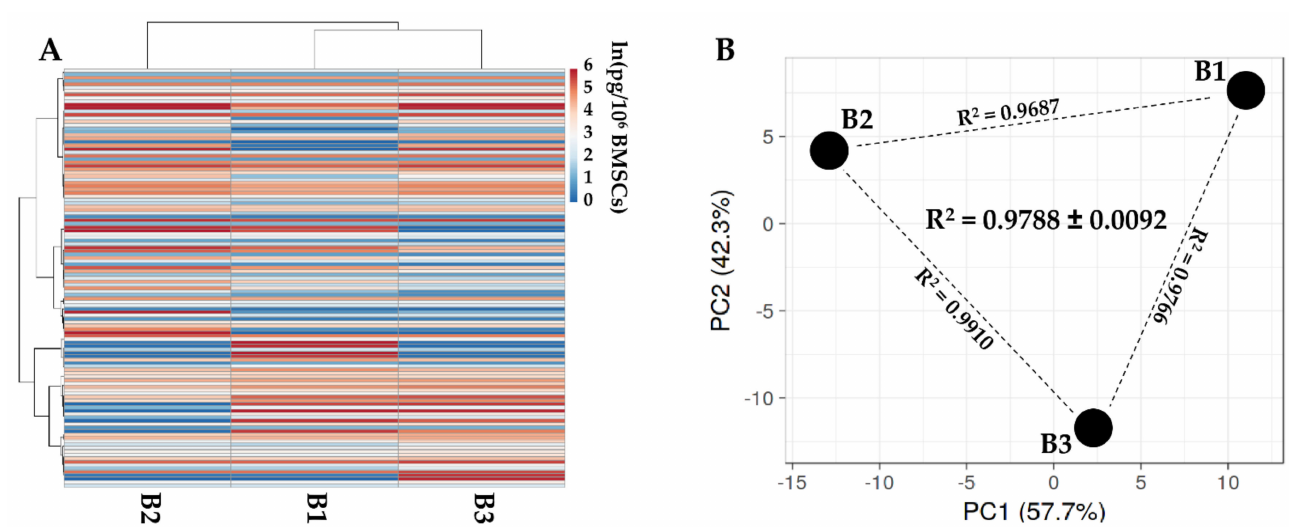
Figure 2. Comparison of secreted factor profiles between SF-treated BMSCs under study. ( A ), heat map of hierarchical clustering analysis of the ln(x) transformed pg/million BMSCs values of detected factors with sample clustering tree at the top. The color scale reflects the absolute expression levels: red shades = high expression levels and blue shades = low expression levels. B1, B2 and B3 stands for BMSC donors 1, 2 and 3. ( B ), principal component analysis of the ln(x) transformed pg/million BMSCs values of detected factors. X and Y axes show principal component 1 and principal component 2, which explain 57.7% and 42.3% of the total variance. B1, B2 and B3 stands for BMSC donors 1, 2 and